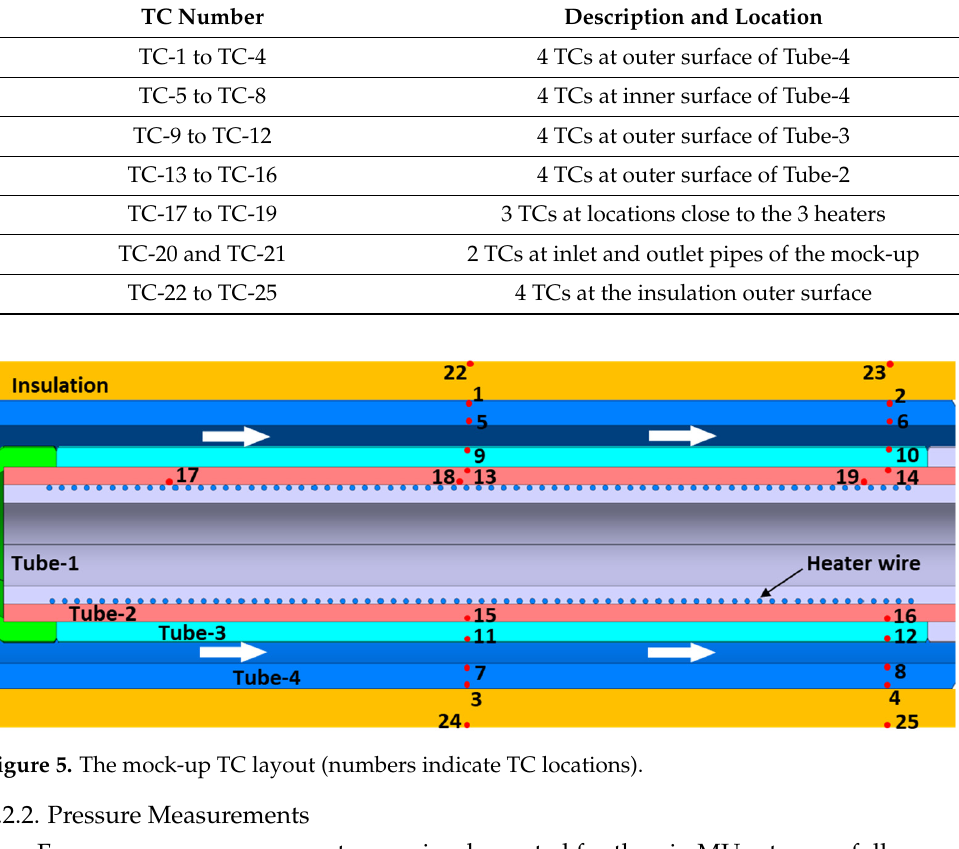
Table 2. List of the thermocouples attached to the pin mock-up.